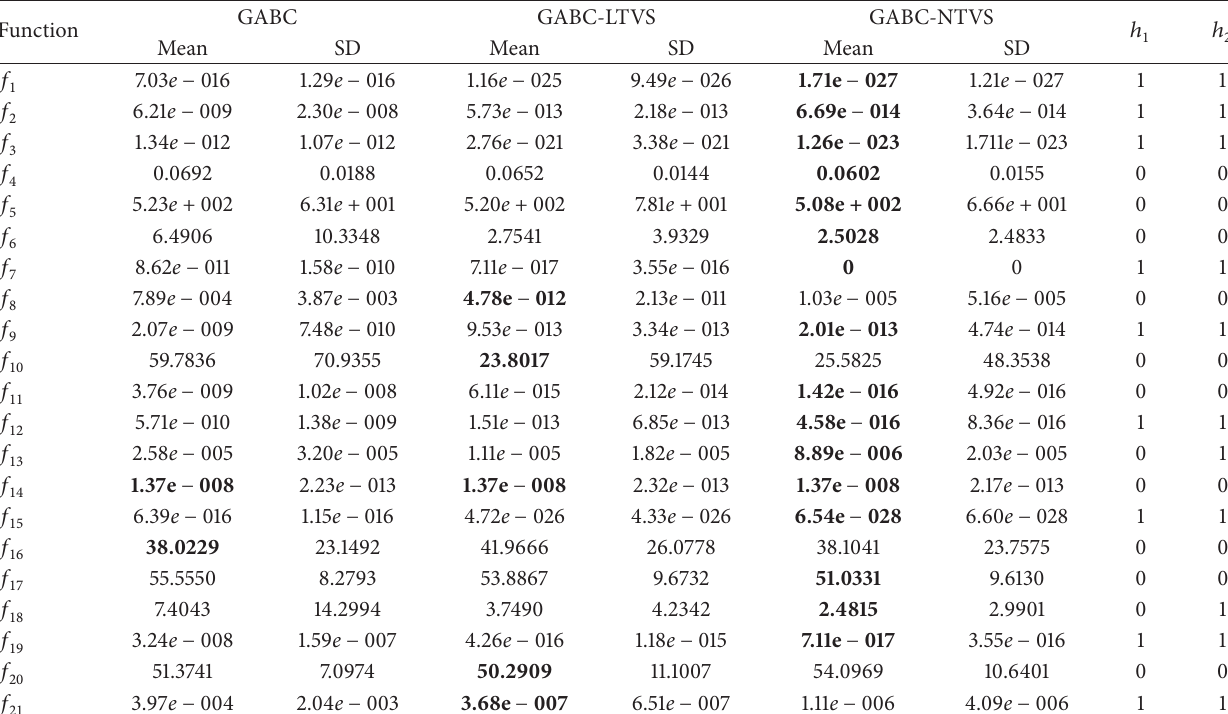
Table 7: Experimental results for 30D problem of GABC